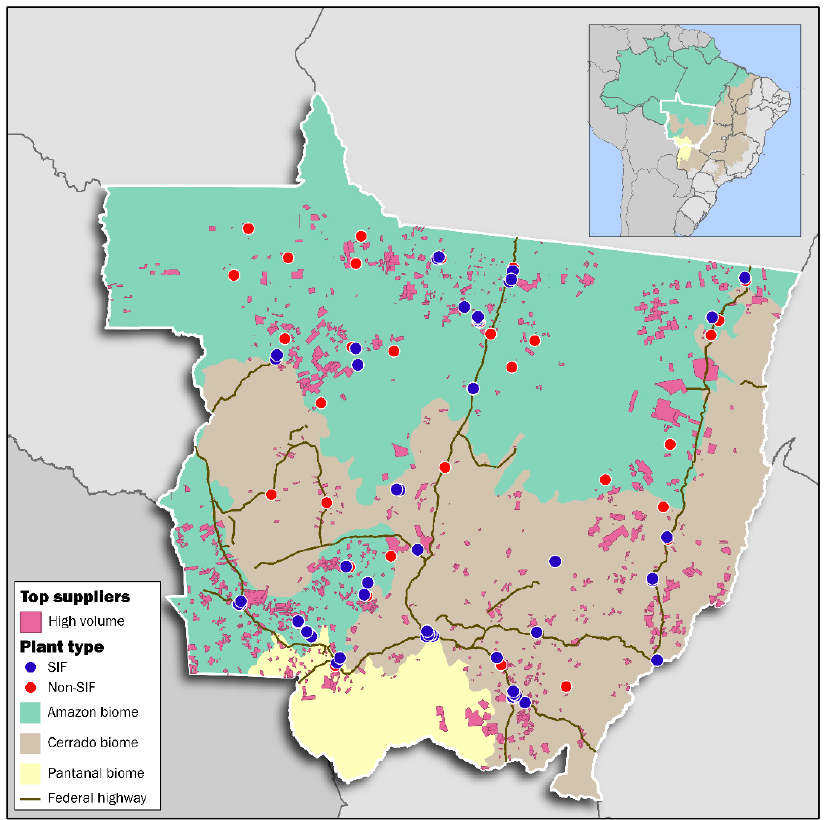
Figure 1. Study area showing the distribution of high-volume properties, and infrastructure of federally (SIF) and non-federally inspected (non-SIF) slaughterhouses and main roads.